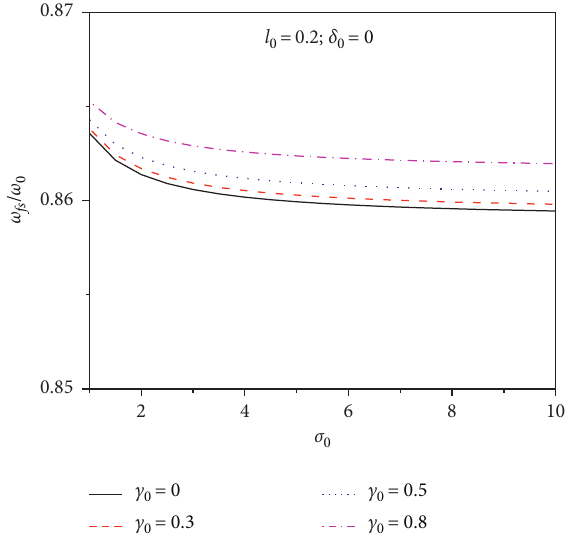
Figure 12: The variation in the ratio ω different values of c c for 0